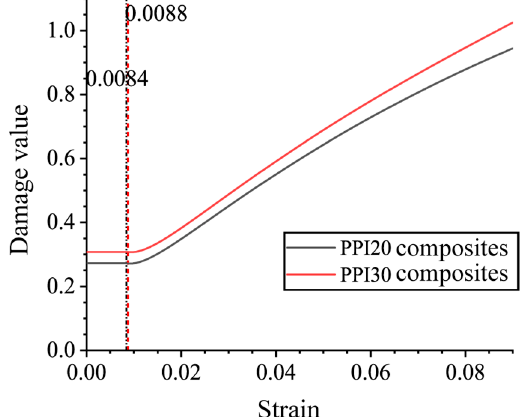
Figure 12. Stress–strain curve of Ni-Fe alloy in tensile test.